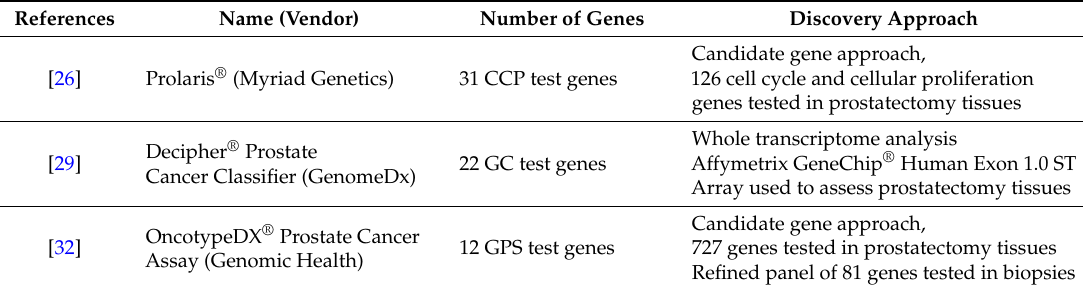
Table 1. Commercially available mRNA test for prostate